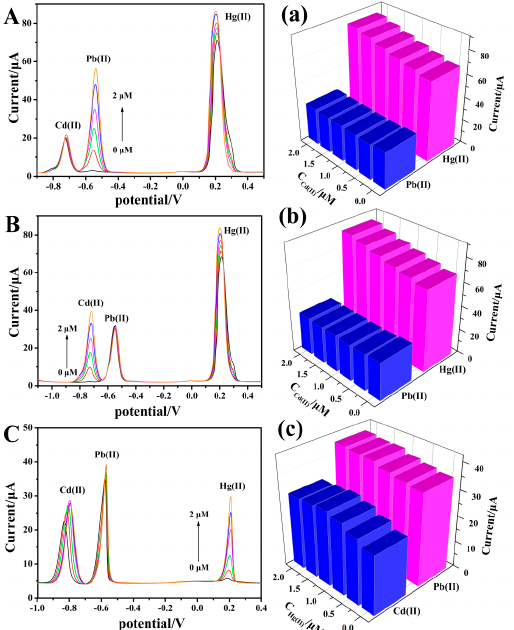
Figure 8. DPV response of the PProDOT(MeSH) 2 @Si/GCE at: ( A ) Pb(II) (0–2.0 μ M), 1.0 μ M Cd(II) and Hg(II); ( B ) Cd(II) (0–2.0 μ M), 1.0 μ M Pb(II) and Hg(II); ( C ) Hg(II) (0–2.0 μ M), 1.0 μ M Pb(II) and 1.0 μ M Cd(II). ( a ), ( b ) and ( c ) comparison of the stripping peak currents of Pb(II) and Hg(II), Cd(II) corresponding to panel A , B and C .